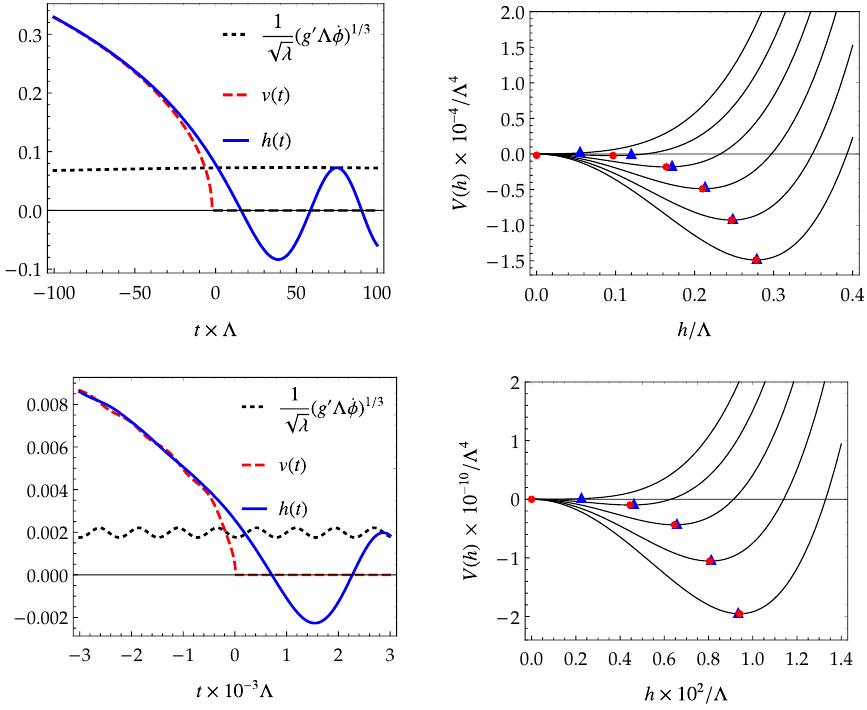
Figure 5 . Left : Higgs (cid:12)eld h ( t ) (blue) and its value at the minimum of the potential v ( t ) (red) as a function of time t in units of (cid:3) (cid:0) 1 . The black curve indicates when the tracking stops from the approximation in (2.21) Right : Higgs potential where the blue points represent the (cid:12)eld value and the red ones the value at the minimum. (cid:3) = 10 4 GeV ; f 0 = 10 6 GeV and (cid:3) b = 7 (cid:2) 10 3 GeV. Top : g 0 = 10 (cid:0) 4 , the Higgs is not e(cid:14)ciently tracking the minimum of its potential (the tracking stops when the value at the minimum is still too large, v (cid:24) 0 : 1 (cid:3)). Bottom : g 0 = 3 (cid:2) 10 (cid:0) 9 , the Higgs is e(cid:14)ciently following its minimum (the tracking stops when the value at the minimum is